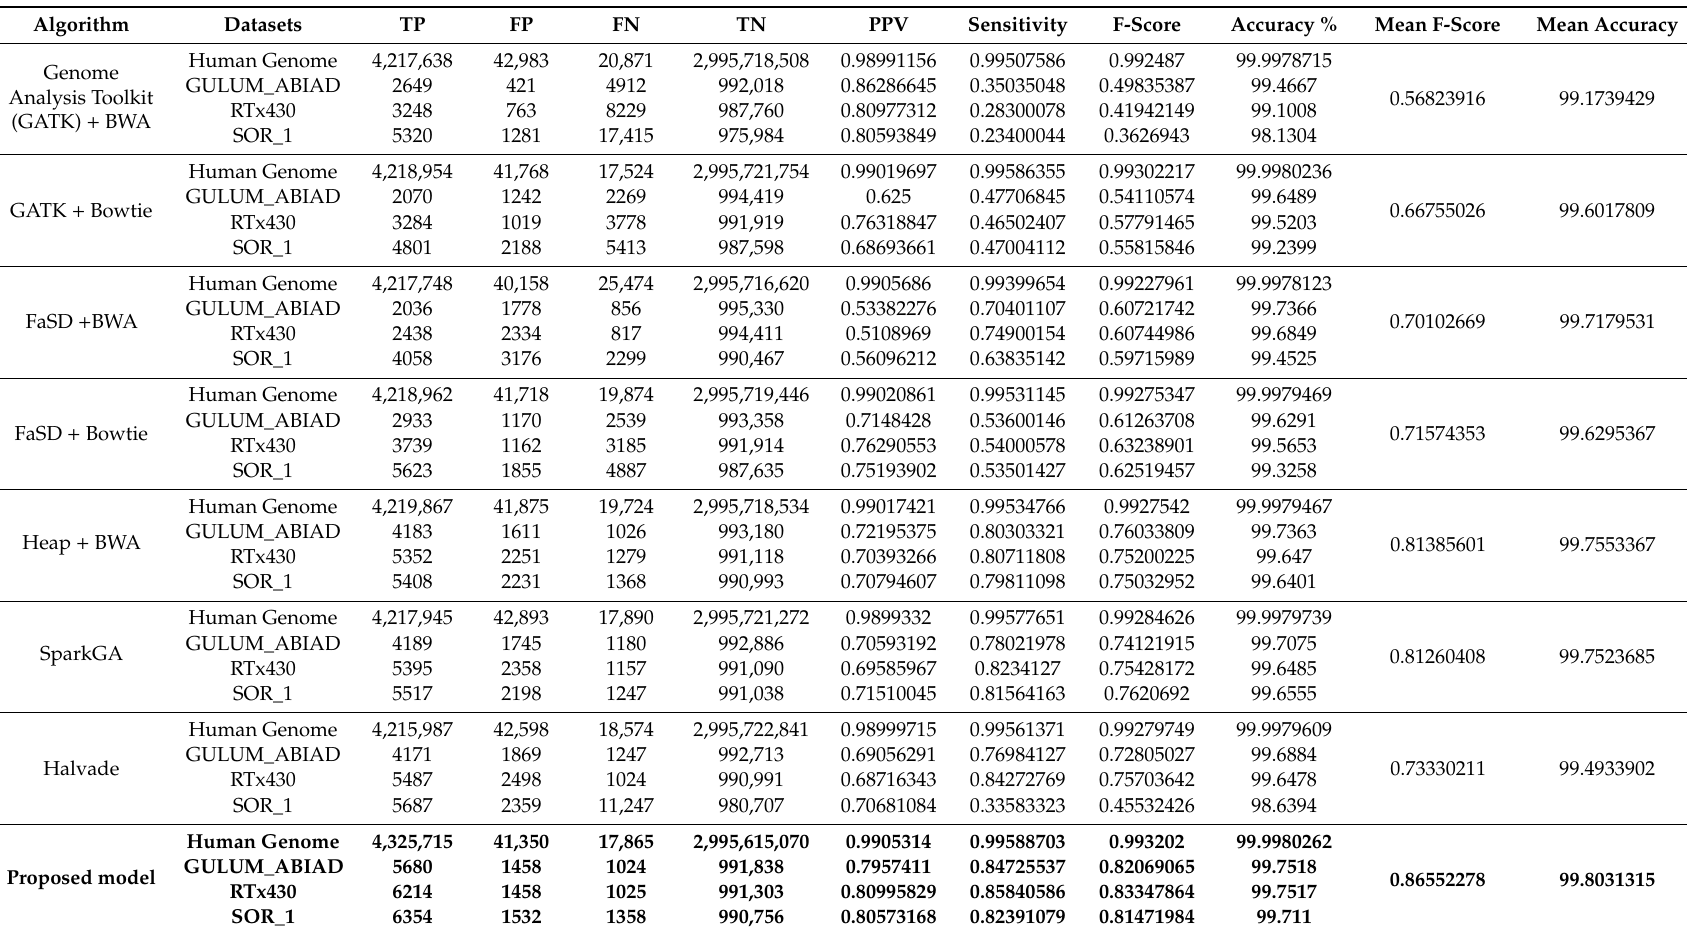
Table 1. Comparative measurement analysis of proposed workflow with other frameworks in terms of mean F-Score and mean accuracy. Bold is used to highlight the proposed method and its